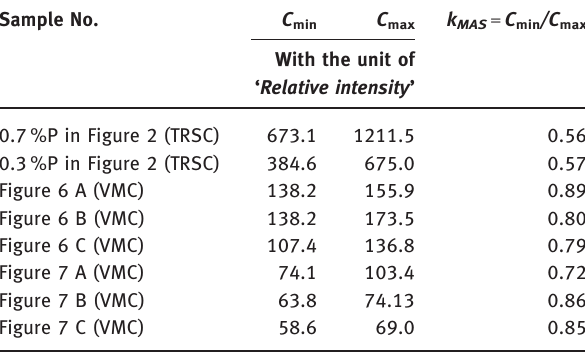
Table 3: Calculated macrosegregation coefficient for TRSC and VMC samples.